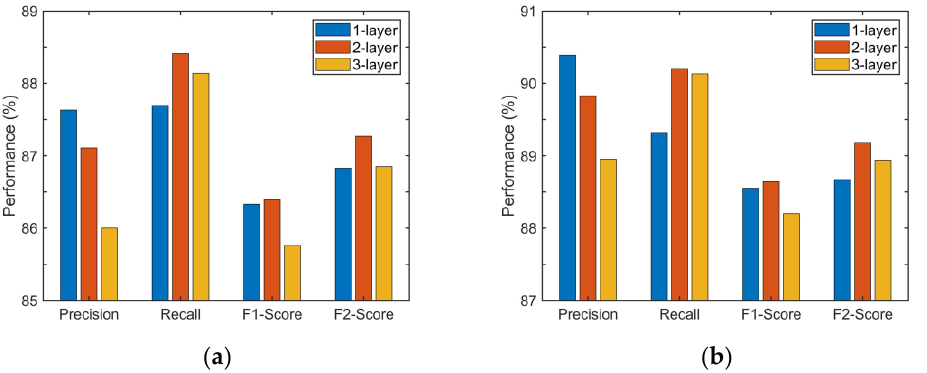
Figure 8. Performance comparisons with different depths of the GNN: ( a ) Performances on the UCM multi-label dataset; ( b ) Performances on the AID multi-label dataset.